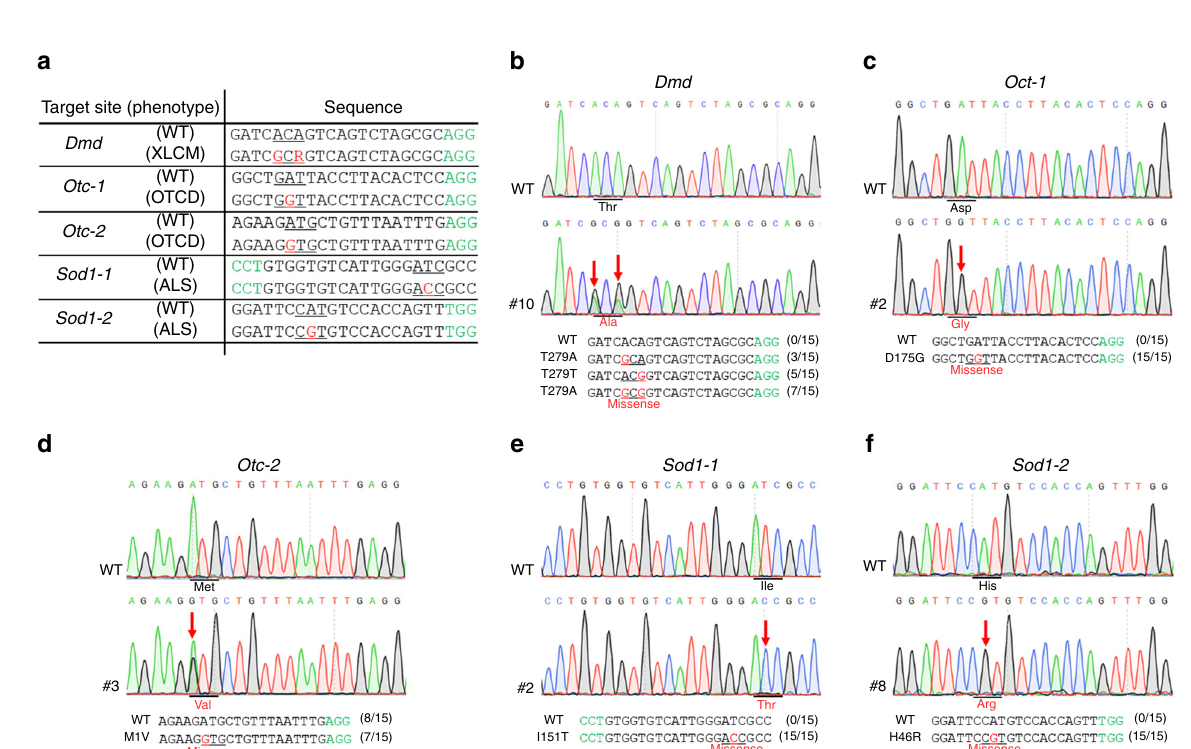
Fig. 5 ABE7.10 induces the ef fi cient A-to-G base editing in rabbit blastocysts. a Target site sequences within the Dmd , Otc-1 , Otc-2 , Sod1-1, and Sod1-2 loci. Target sequence (black), PAM region (green), target sites (red, R = A/G), and mutant amino acid (underlined). WT wild-type. b – f Representative sequencing chromatograms at Dmd , Otc-1 , Otc-2 , Sod1-1 , and Sod1-2 targets of WT and edited rabbit blastocysts. Target base editing (red arrows), target sequence (black), PAM region (green), target sites (red), mutant amino acid (underlined), and amino acid mutation type are indicated. The relevant codon